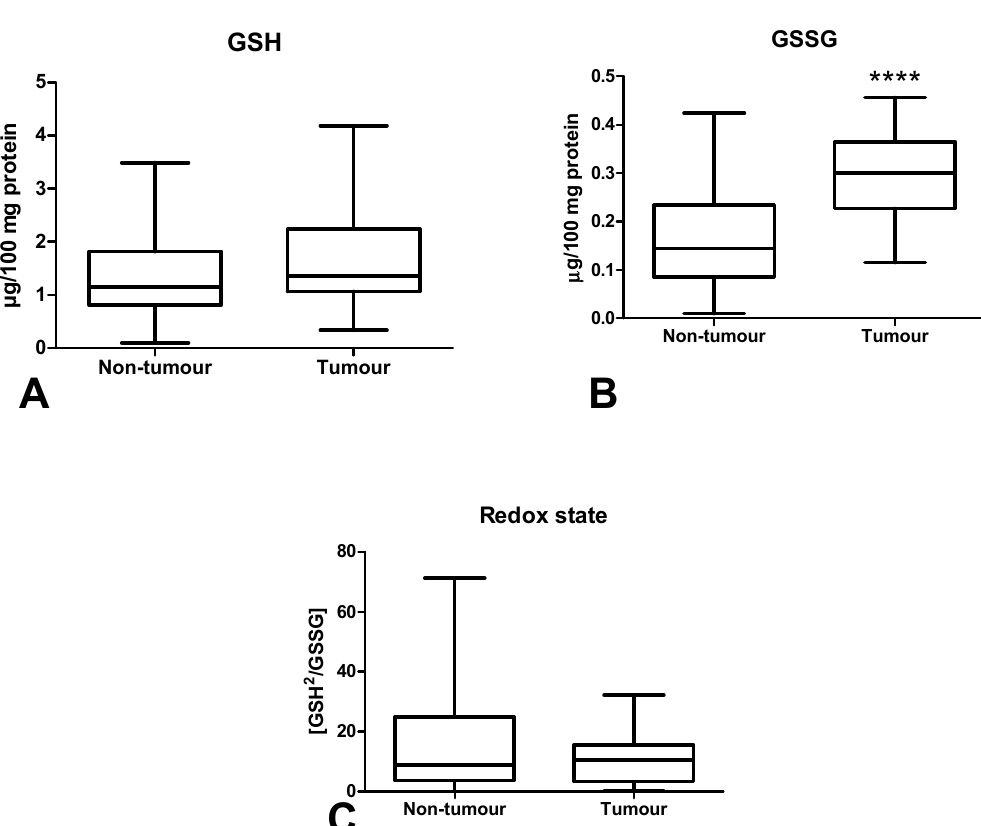
Figure 4. Comparison of GSH ( A ) and GSSG ( B ) concentration and redox state ( C ) between colorectal cancer tissue ( n = 29) and normal mucosa ( n = 29). Abbreviations: GSH—reduced glutathione, GSSG—oxidized glutathione (GSSG). The data are presented as median (minimum–maximum). **** p < 0.0001.